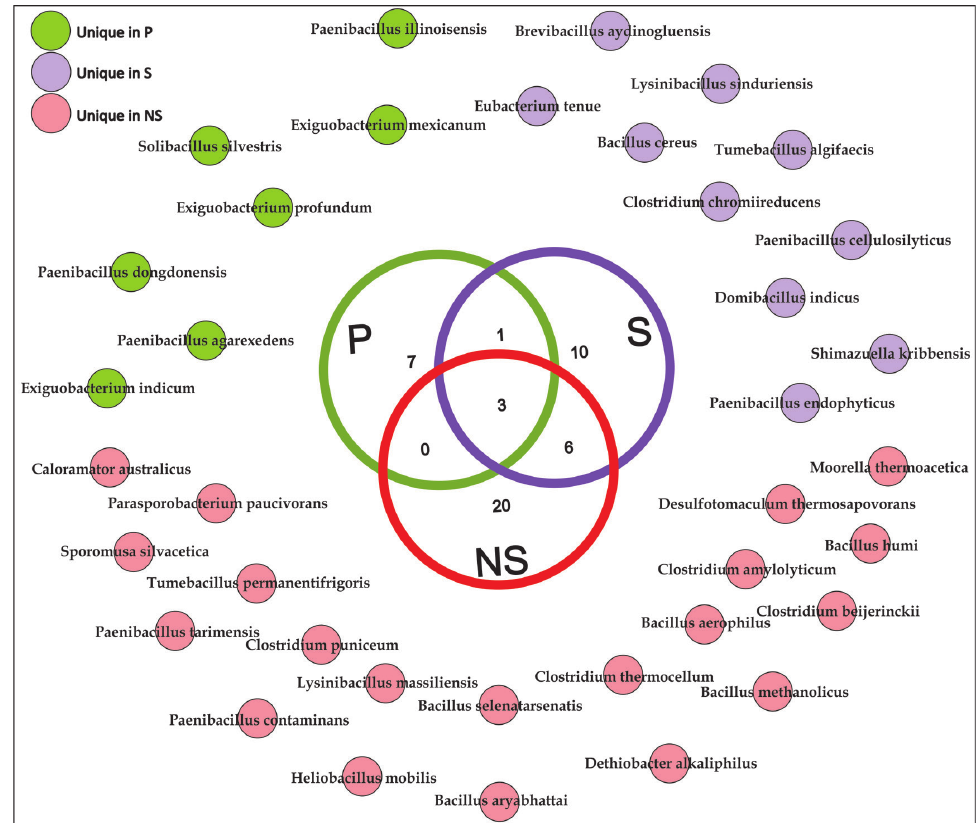
Fig. 3. Chart showing the sharing of all observed bacterial species of Firmicutes phylum for root-associated soil microbiome. These species-level taxonomic assignments were derived at 97 % sequence similarity using EzTaxon-e